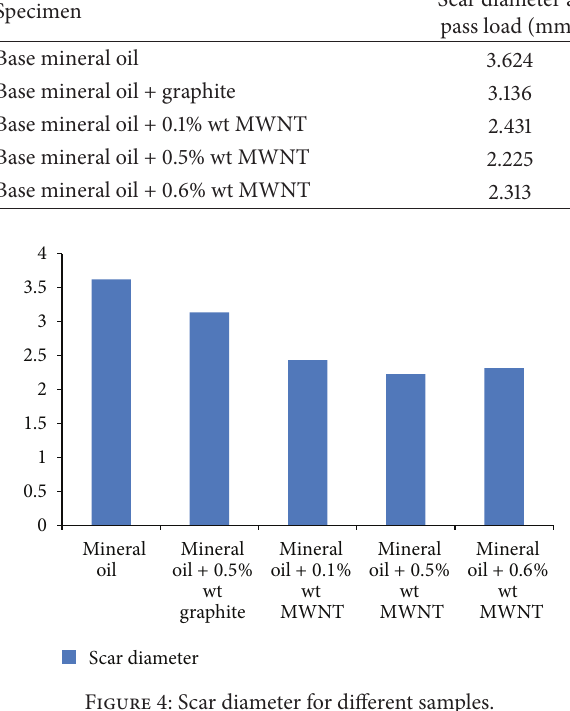
Table 5: Frictional torque at pass